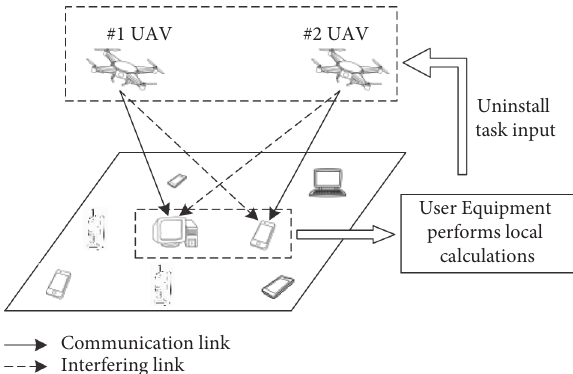
Figure 1: Multi-UAV-assisted mobile edge computing